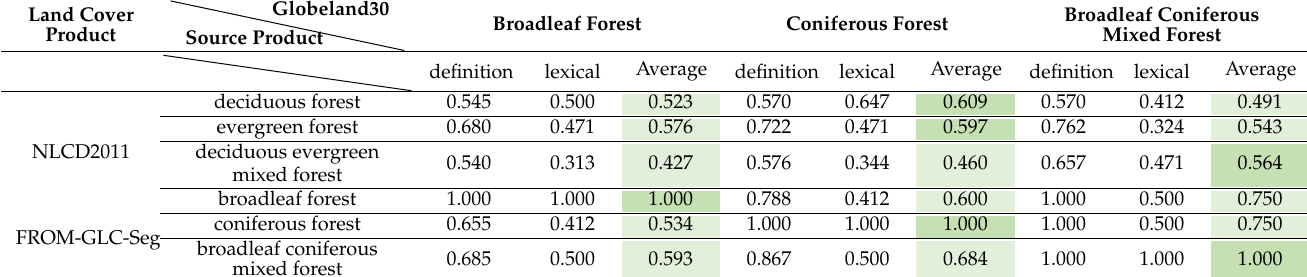
Table 4. Results of mapping based on term